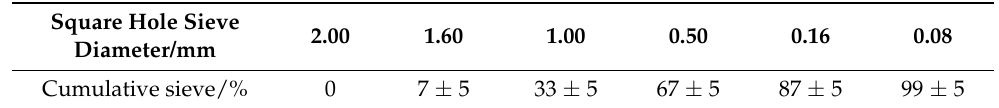
Table 2. Particle size